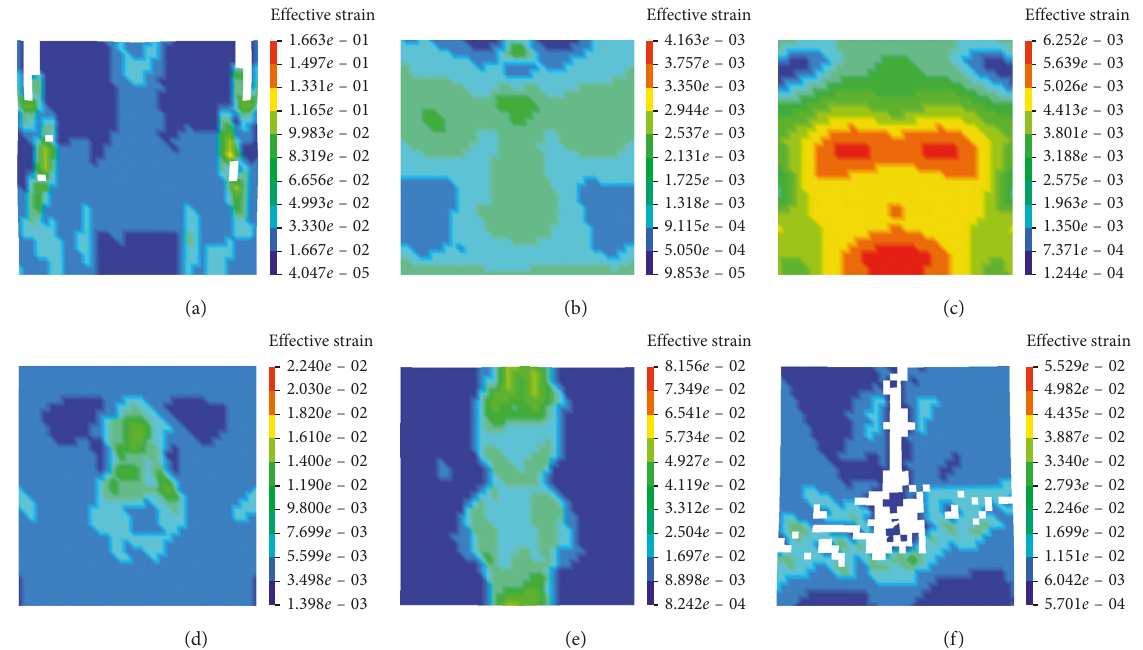
Figure 8: Relationship between effective strain and constraint static load of impact of coal rock. (a) q (d) q 3MPa. (e) q (cid:31)